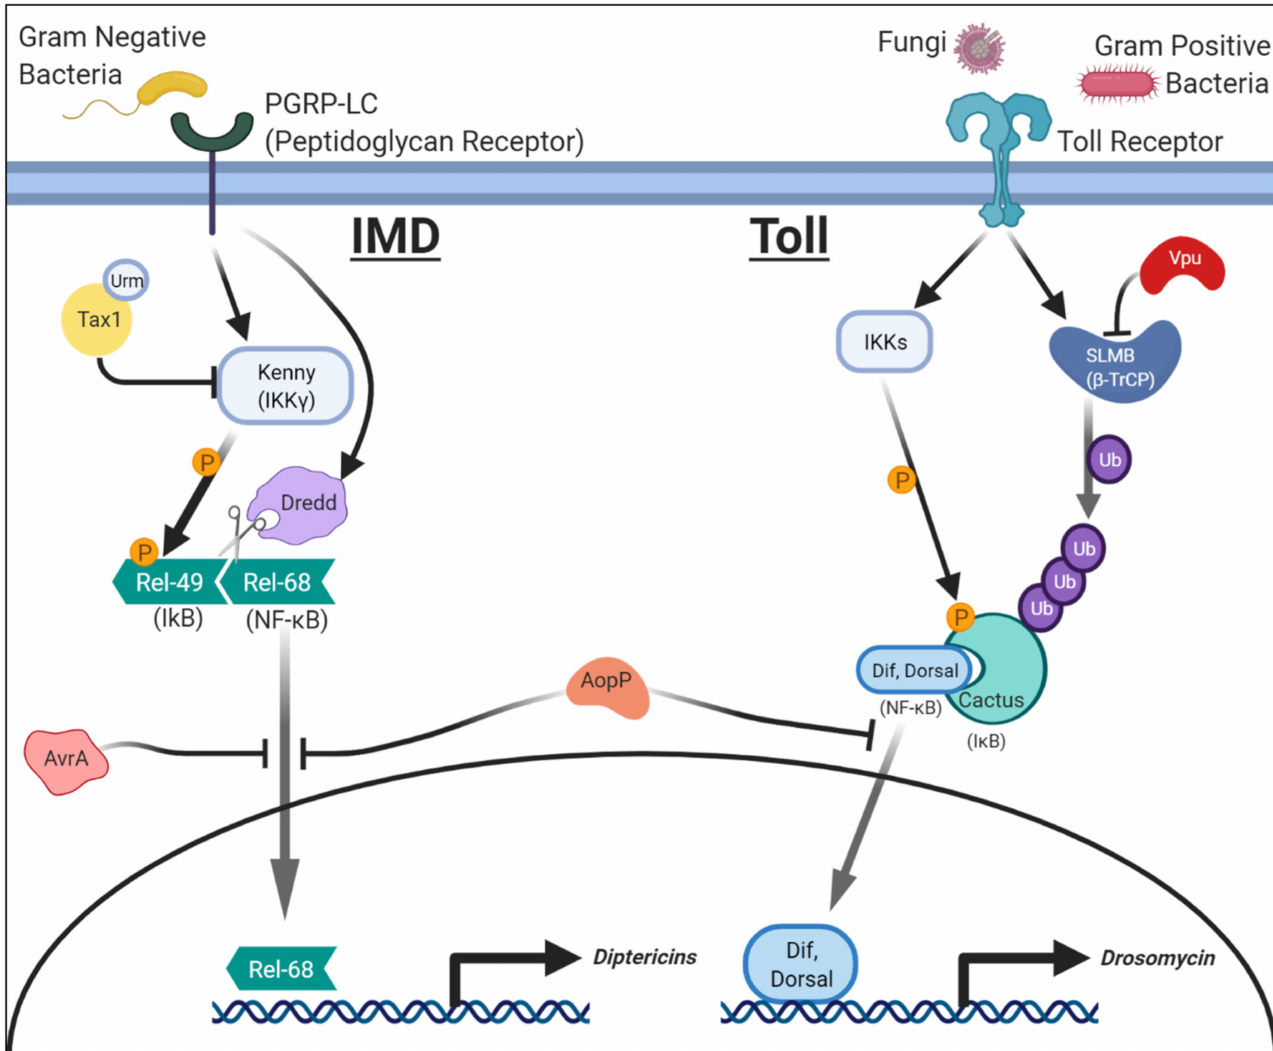
Figure 1. Virulence factors that affect immunological signaling pathways studied in Drosophila . Core components of the immune deficiency (IMD) ( left ) and Toll ( right ) branches of the NF- κ B signaling pathway are depicted along with pathogenic proteins that target these pathways. Host proteins shown in cool colors and pathogenic proteins (AopP ( Aeromonas salmonicida ), and AvrA ( Salmonella enterica ), Tax1 (HTLV-1)) are shown in warm